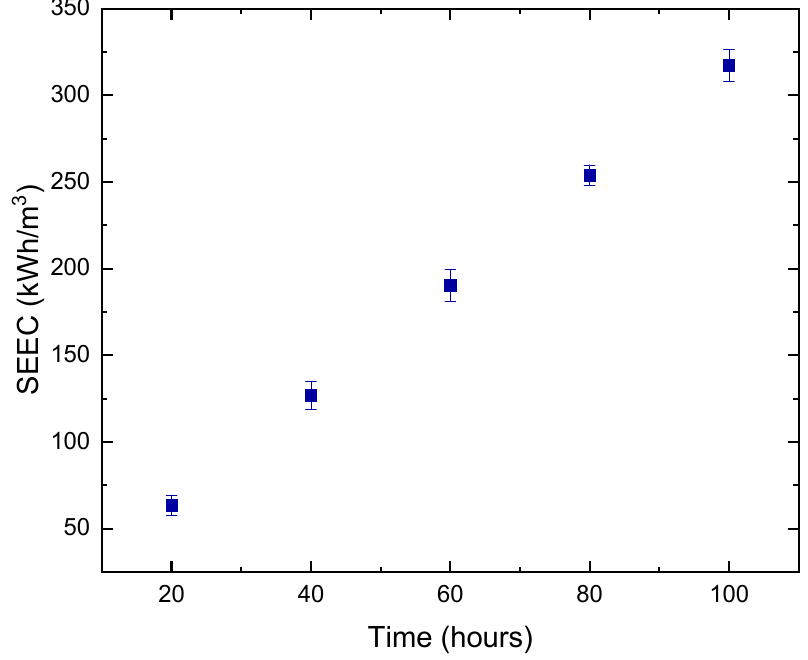
Figure 12. Specific electrical energy consumption calculated over time for MD pilot unit. Generally, in DCMD, the pumps, electrical heating inside the feed tank, and external water coolant running through the coolant spiral inside the distillate tank, all lead to the consumption of electrical energy. In Figure 13, the overall heat input raised, resulting in an increase in the pilot system’s STEC from starting points of 35.51 and 43.667 kWh/m 3 , for C2 and C1, respectively. This agrees with some findings in the literature [58]. Feed salinity plays a significant role in determining the thermal energy consumption of an MD system. With the reduction in feed concentration, as presented in Figure 13a, there was a 19% drop in STEC after the first 20 h. The total reduction in STEC at higher feed concentrations was greater than that of lower concentrations, with 37% and 21%, respectively. This was due to the direct effect of feed salinity on the viscosity and mobility of the stream passing through the membrane, which in turn affects the vapor pressure of the solution [59]. In this work, the feed and permeate inlet temperatures were fixed at T Fin = 70 ◦ C, T Pin = 20 ◦ C, respectively. The flowrates of Q F = Q P = 70 LPH were equal for both the feed and permeate streams, respectively. The specific heat capacity was assumed constant in the whole pilot system. The minimal values of the STEC between 40 and 90 h of continuous DCMD pilot operation were reached as a result of the fouling effect on the system’s thermal performance. The formation of the fouling layers on the membrane surface raised the overall membrane thermal resistance and lowered its overall heat transfer coefficient. As depicted earlier in Figures 3 and 4, as a function of operating time, an increase in the attachment of foulants onto the membrane surface took place. In the presence of inorganic compounds and chemical substances, both high ionic strength